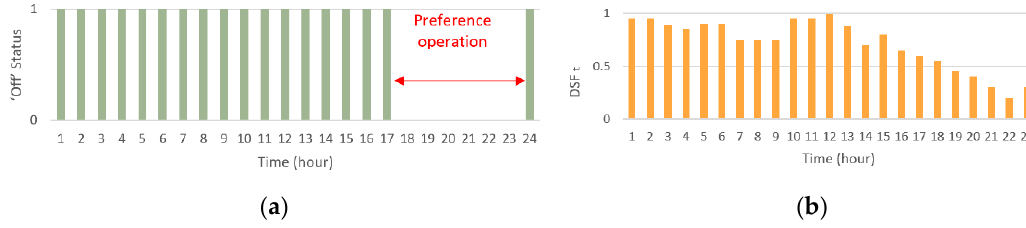
Figure 5. ( a ) Simple dissatisfaction weight approach using binary values and ( b ) DSF t weight by each time slot of the proposed model. Table 1. Cost comparison according to the set dissatisfaction weight approach.